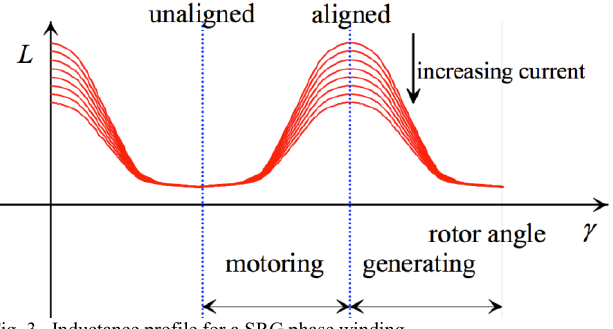
Fig. 3. Inductance profile for a SRG phase winding.